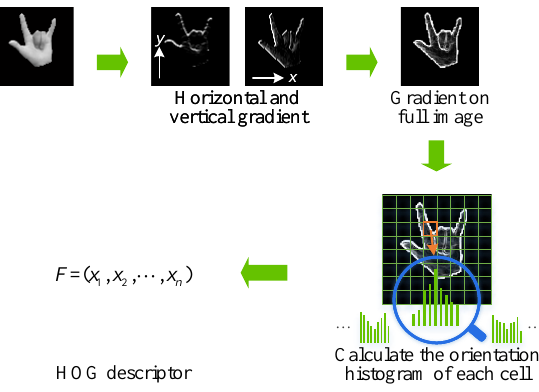
Figure 3. The calculation of HOG feature.